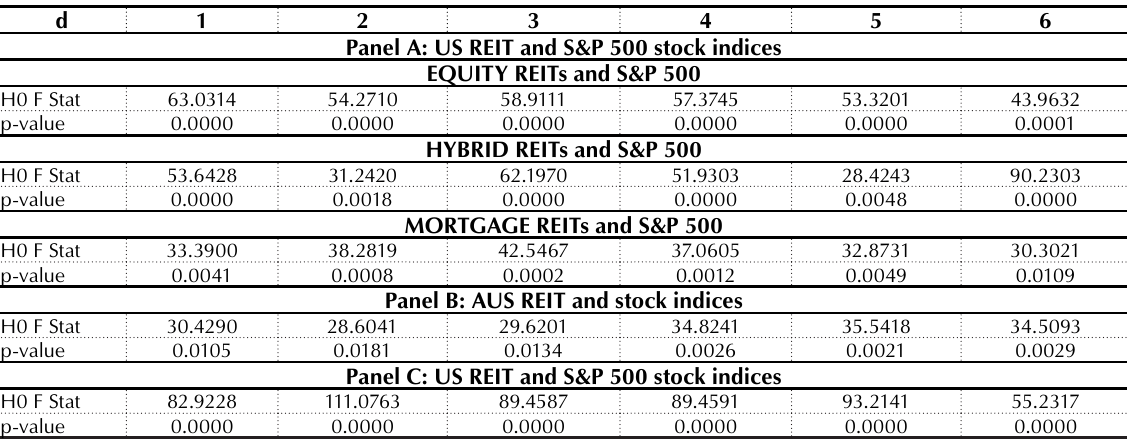
Table 3. Nonlinear